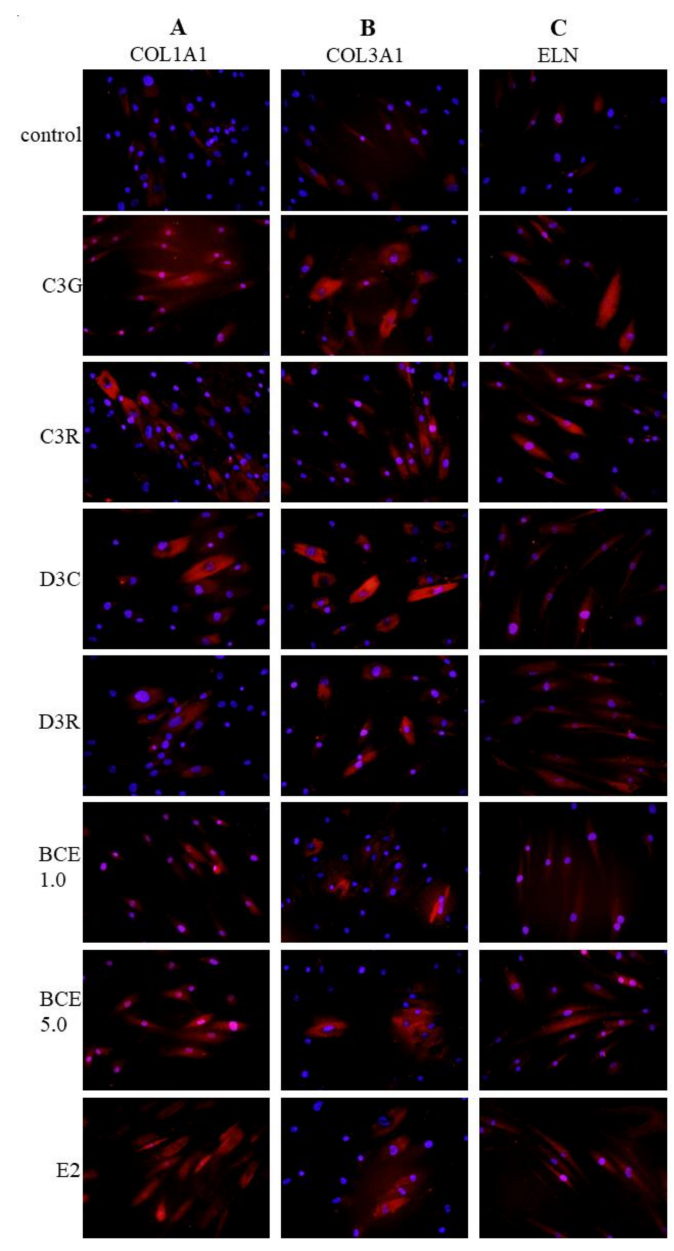
Figure 2. Effects of blackcurrant anthocyanins and E2 on the protein levels of COL1A1 ( A ), COL3A1 ( B ), and elastin ( C ). TIG113 cells were treated with the indicated anthocyanins (10 µ M), BCE (1.0 or 5.0 µ g/mL), or E2 (1 nM) for 48 h. Cells were stained, as indicated, using an anti-COL1A1, anti-COL3A1, or anti-elastin antibody (red signals). The nuclei were visualized using DAPI (4 (cid:48) ,6-diamidino-2-phenylindole, blue). Images are at 200 ×